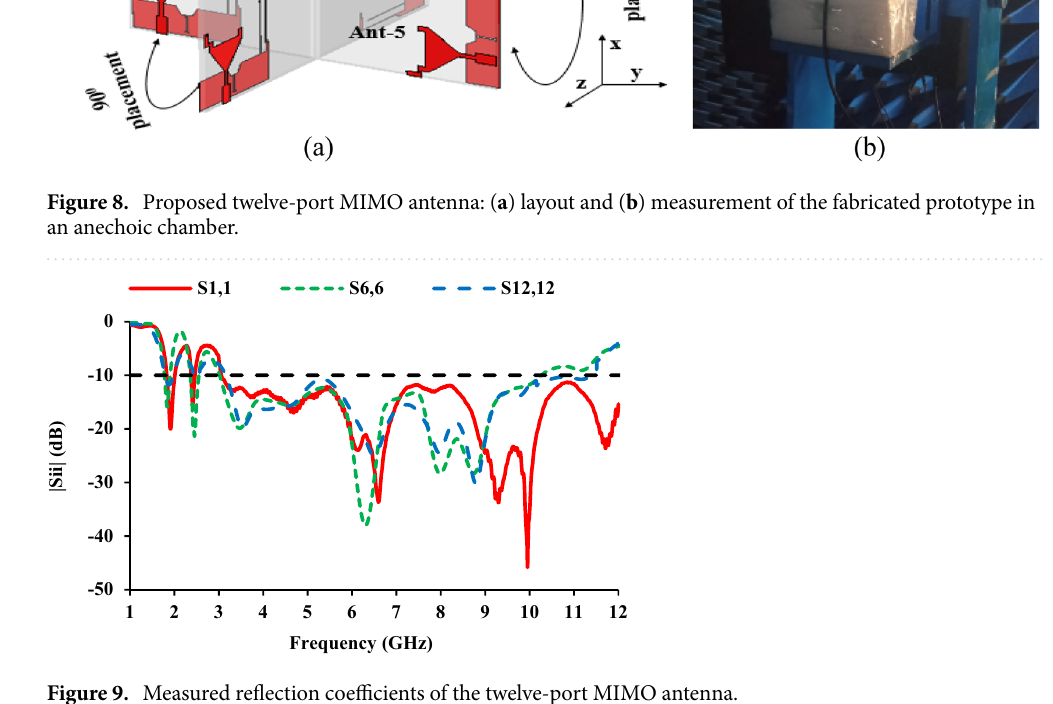
Figure 9. Measured reflection coefficients of the twelve-port MIMO